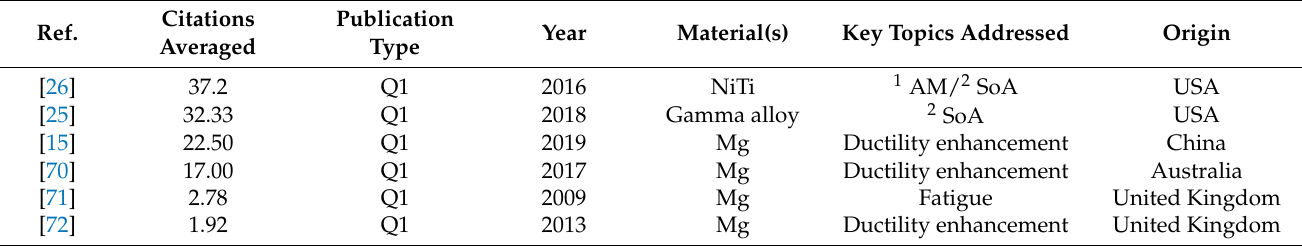
Table 7. Summary of studies including magnesium and special alloys, listed by the average number of citations, taking into account the number of years the article has been published.